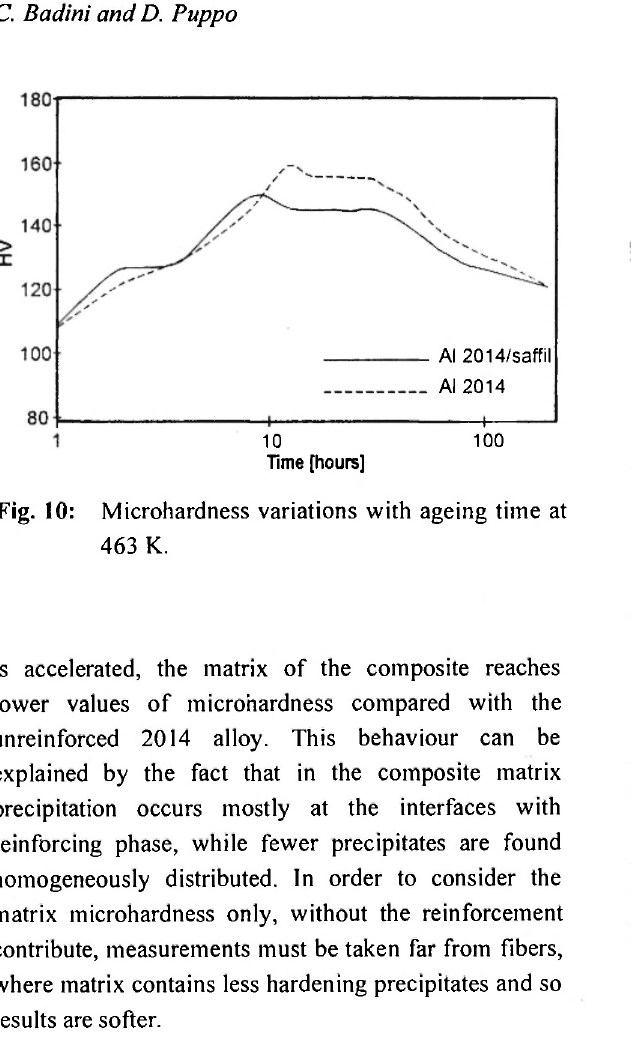
Fig. 11: Macrohardness variations with ageing time at 463 K.